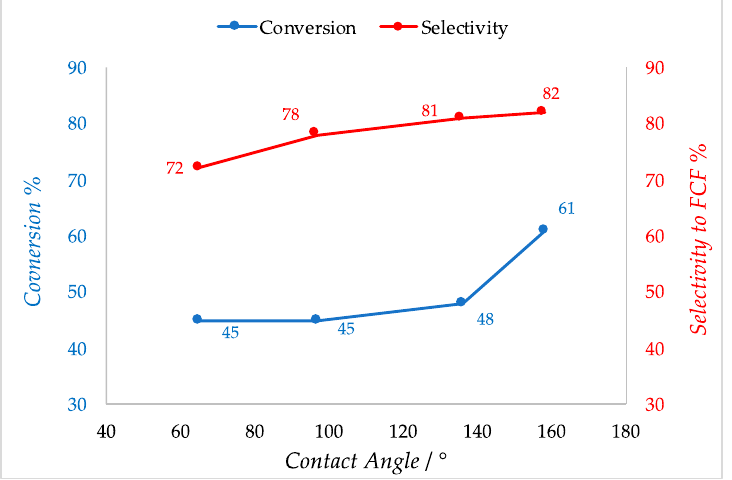
Figure 4. Conversion and selectivity of Polystyrene resins vs contact angles in the hydroxyalkylation/alkylation of 2-methylfuran (2-MF) with ketones. Adapted from Reference [38].